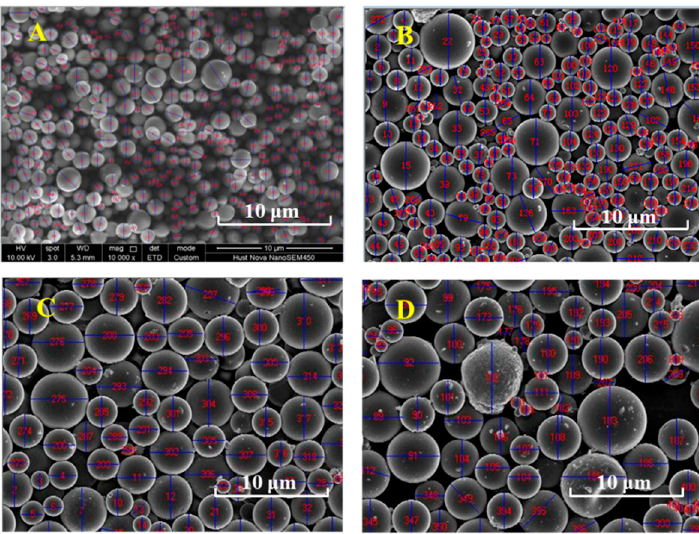
Figure 7. Scanning electron micrographs of the four spherical quartz aerosol samples of A, B, C and D, respectively (scale 10 μ m).